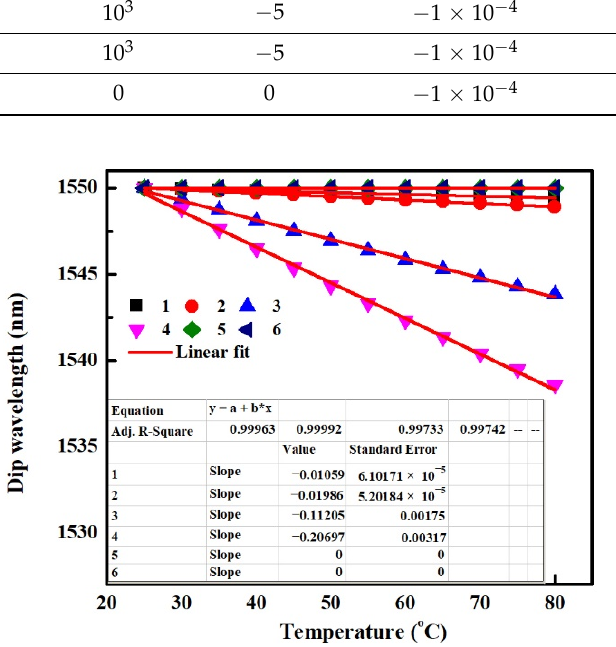
Figure 10. Dip Wavelength as a function of the temperature for SMS fiber structures, various thermal effects are all taken into account in the simulation.